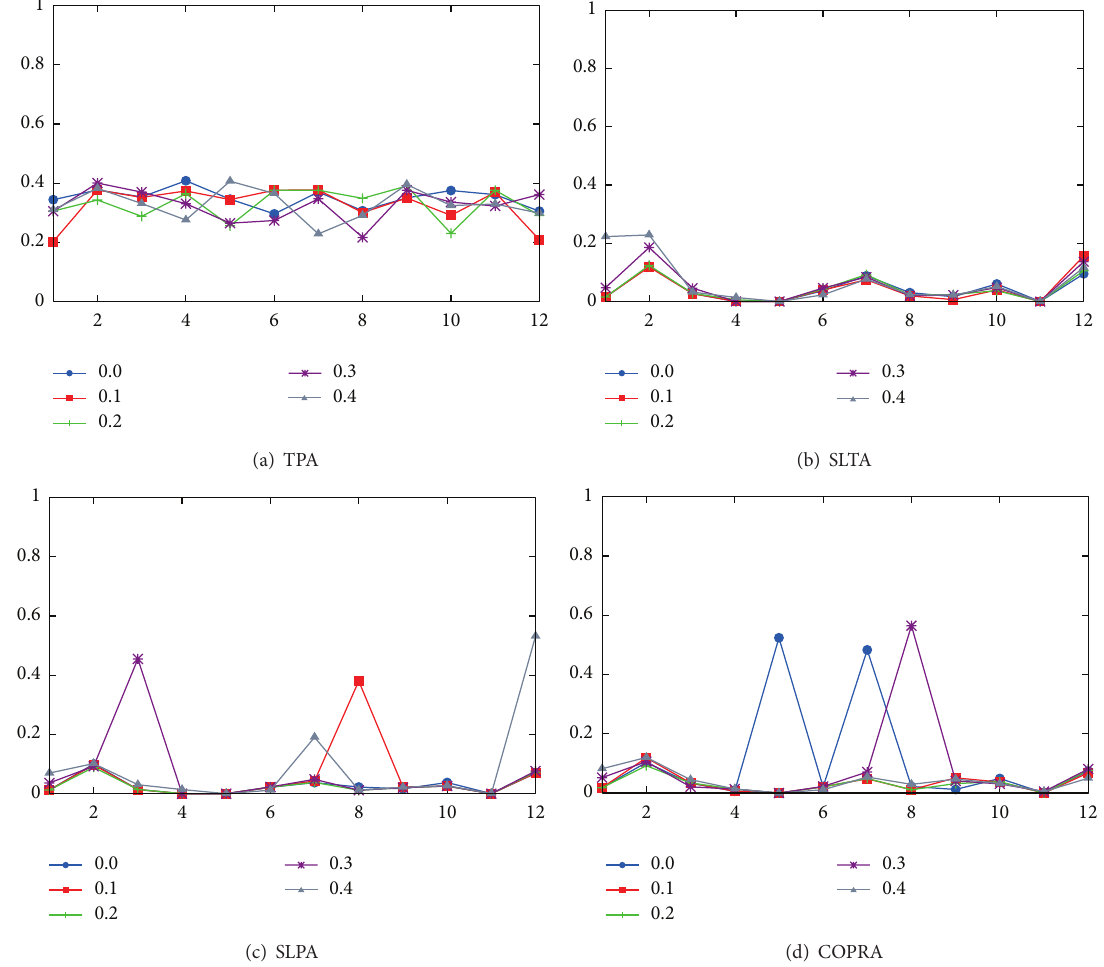
Figure 2: Effects of different semantic LDA-Filter on algorithms using one-month TVC (we include 2009).